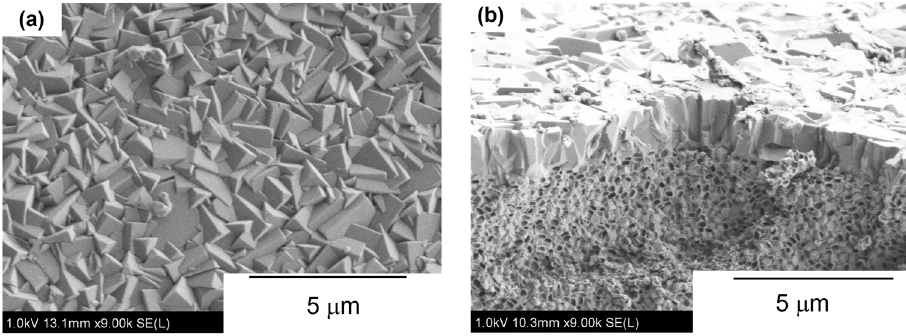
Figure 5. Typical FE-SEM images of prepared membrane. ( a ) surface; ( b ) cross-section.